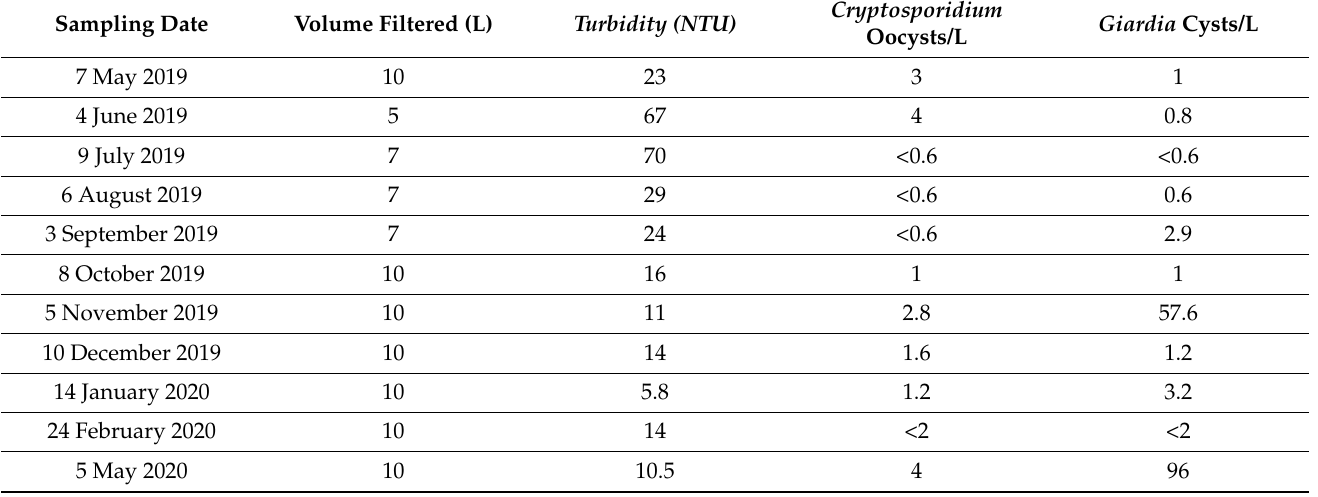
Table 3. Sampling date, volume filtered, turbidity and Cryptosporidium and Giardia (oo)cyst concentration/L at the Danube Canal from May 2019 until September 2020. The sample limit of detection (<) is given when no Cryptosporidium and Giardia (oo)cyst were